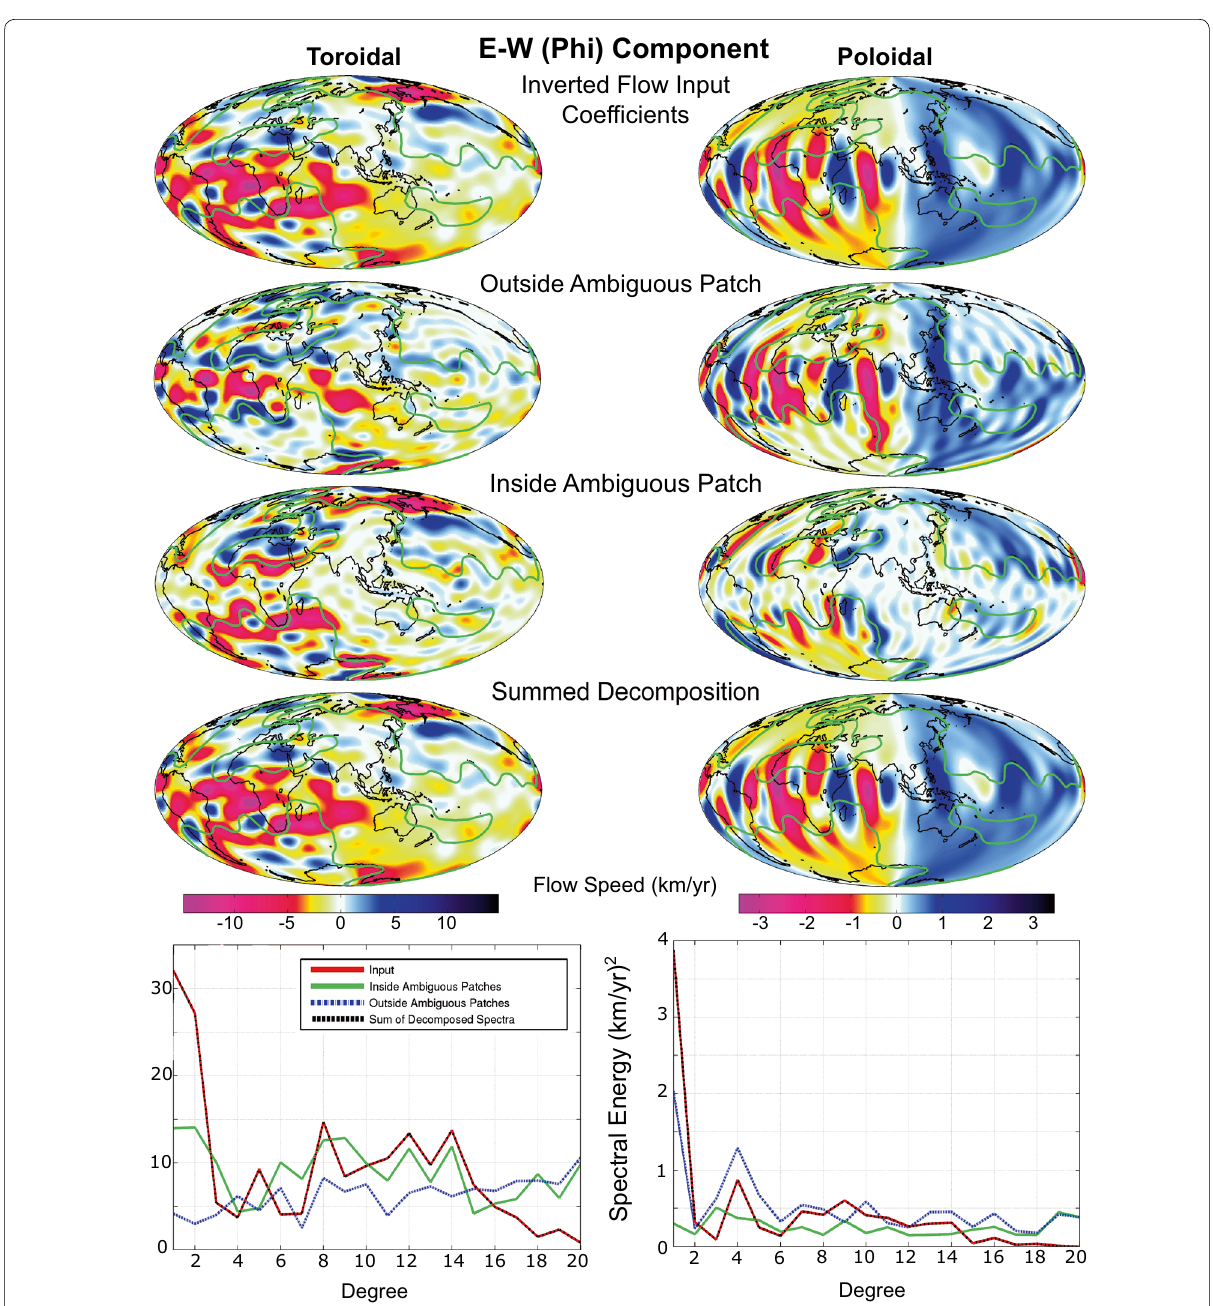
Fig. 7 Decomposition of inverted flow from satellite data in eastward direction ( u φ ). Decomposition of steady flow model obtained from satellite data (up to degree 20) using an ‘optimum’ value of K 199 (coefficients out of 441) to represent flow within the patch. The Shannon number = 178 ) produced a similar decomposition, but the unwanted boundary signals were slightly larger compared to the optimum K decomposition, ( K = which is shown in this